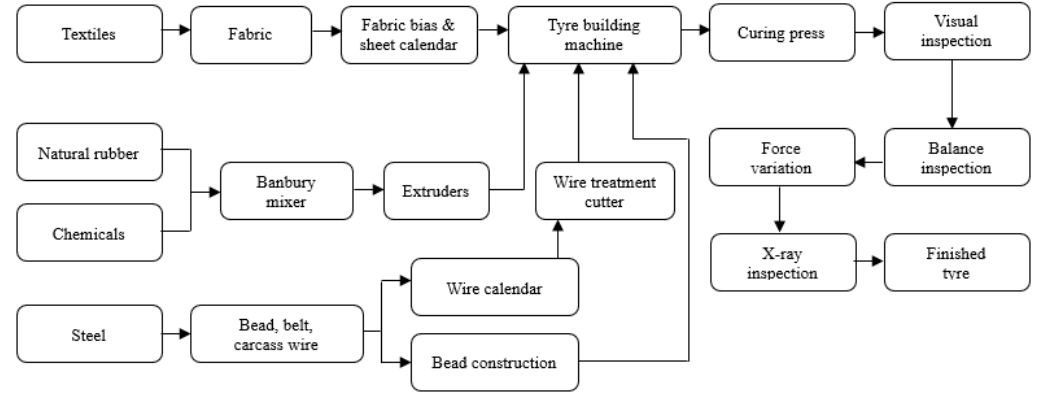
Figure 1. Tire production flow chart.